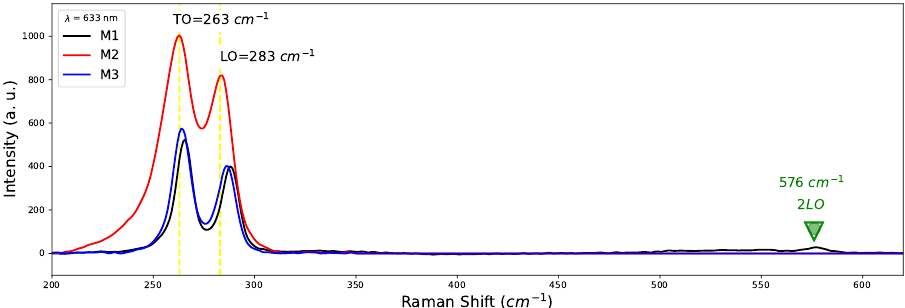
Figure 4. Raman spectra of samples M1, M2, M3 of GaAs grown by CSVT technique. For the nitriding process, samples of GaAs/Si (M1, M2, and M3) were exposed to the ammonia environment for 30 minutes. The XRD patterns of nitrided samples named M4, M5, and M6 are shown in Figure 5. It can be seen diffraction planes of GaN related to a wurtzite structure at (100), (002), (101), (110), and (112) located at position 2 θ : 32.45 ◦